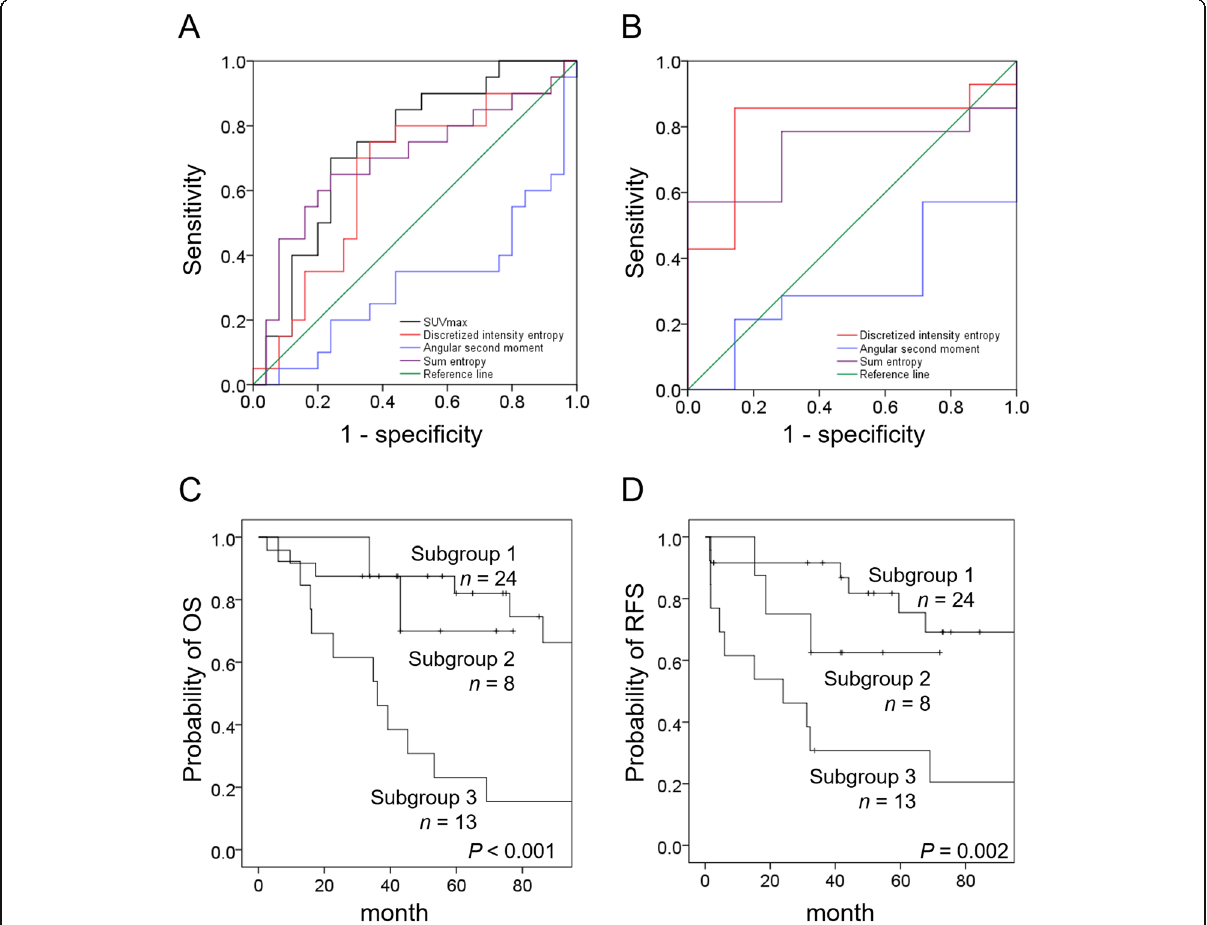
Fig. 1 Kaplan-Meier plots of OS in relation to different PET parameters in the training group ( a ) and in the subgroup of patients with high SUV max ( b ). Kaplan-Meier plots of OS ( c ) and RFS ( d ) according to the three PET risk